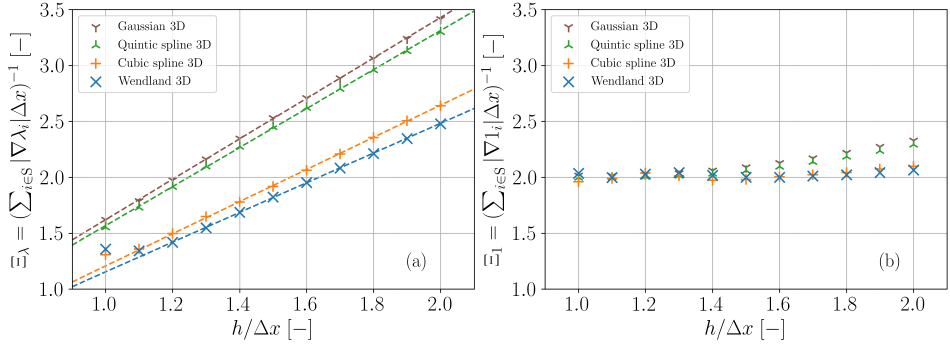
Figure A4. Normalization factors for the surface delta functions for different 3D kernels if the surface calculations are restricted to two particle layers. ( a ) Based on the minimum eigenvalue of the inverse renormalization tensor. ( b ) Based on the unity field.